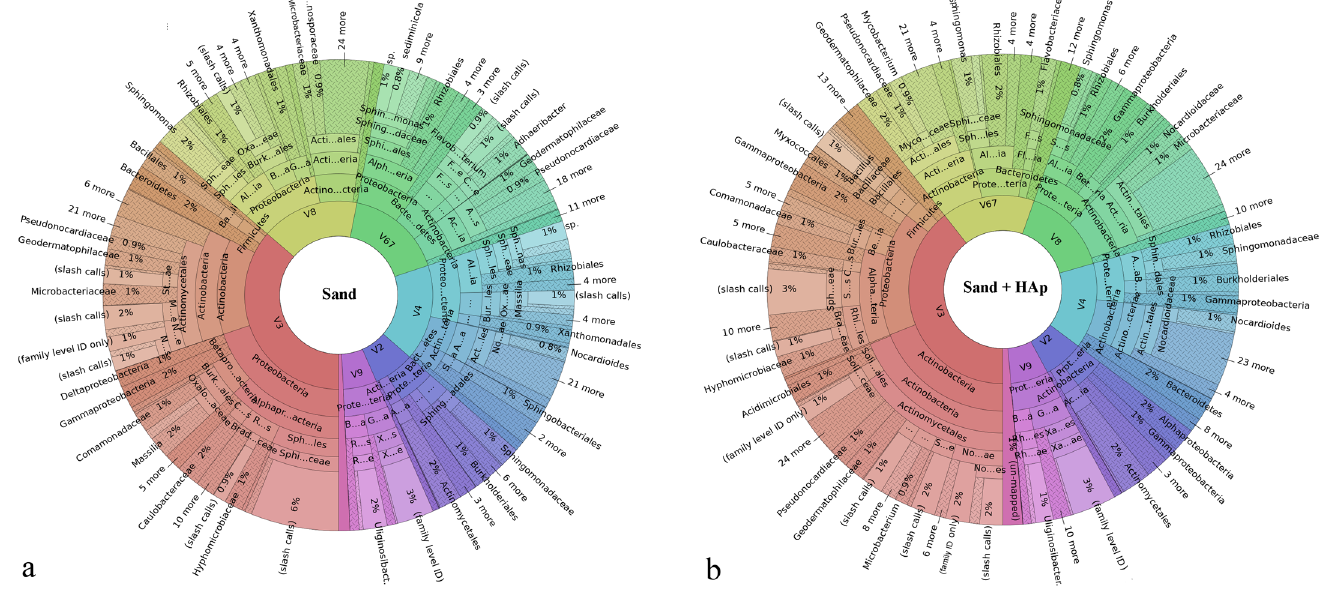
Figure 1. Krona plots representing the microbiome composition of the sandy soil before ( a ) and after ( b ) the treatment with HAp nanoparticles sorted out by primers (V2-4-8 and V3-6,7-9) targeting different variable regions of the 16S ribosomal